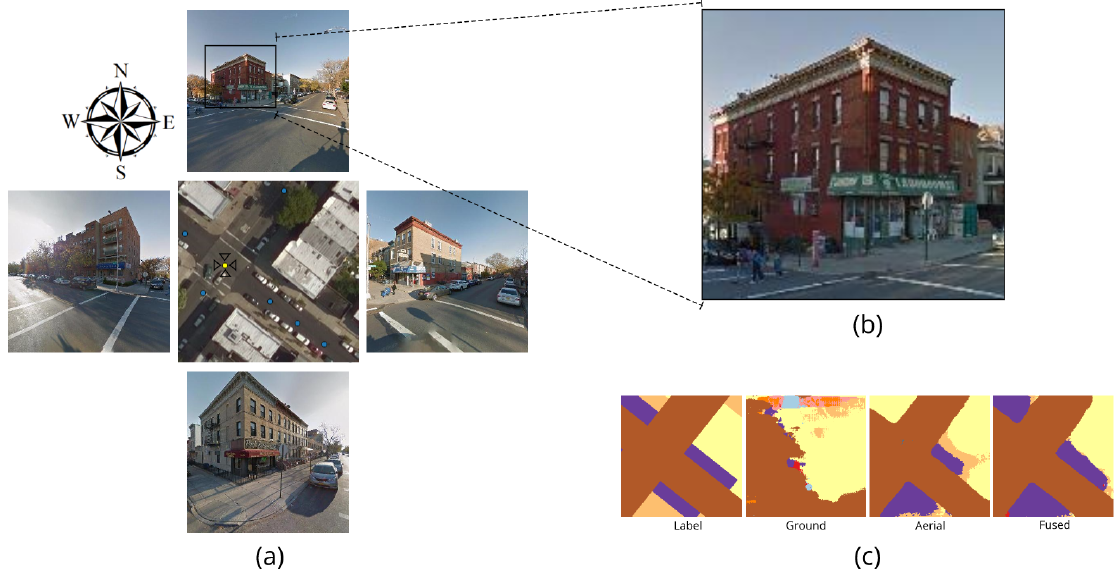
Figure 11. Case study on segmentation results from Brooklyn validation set. ( a ) Aerial and street view images; ( b ) Zoomed view of the building to the north; ( c ) Corresponding segmentation